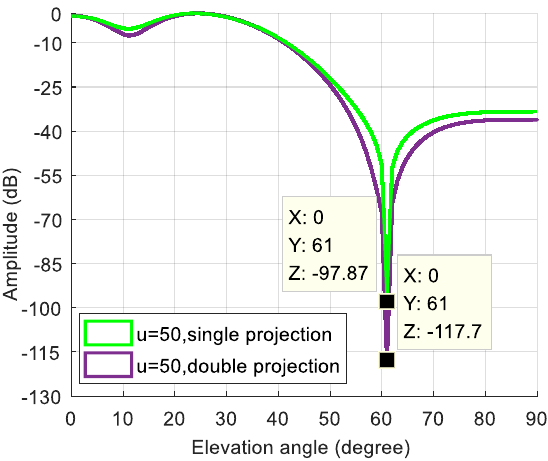
Figure 23. The depth of the nulling corresponding to single projection and double projection.